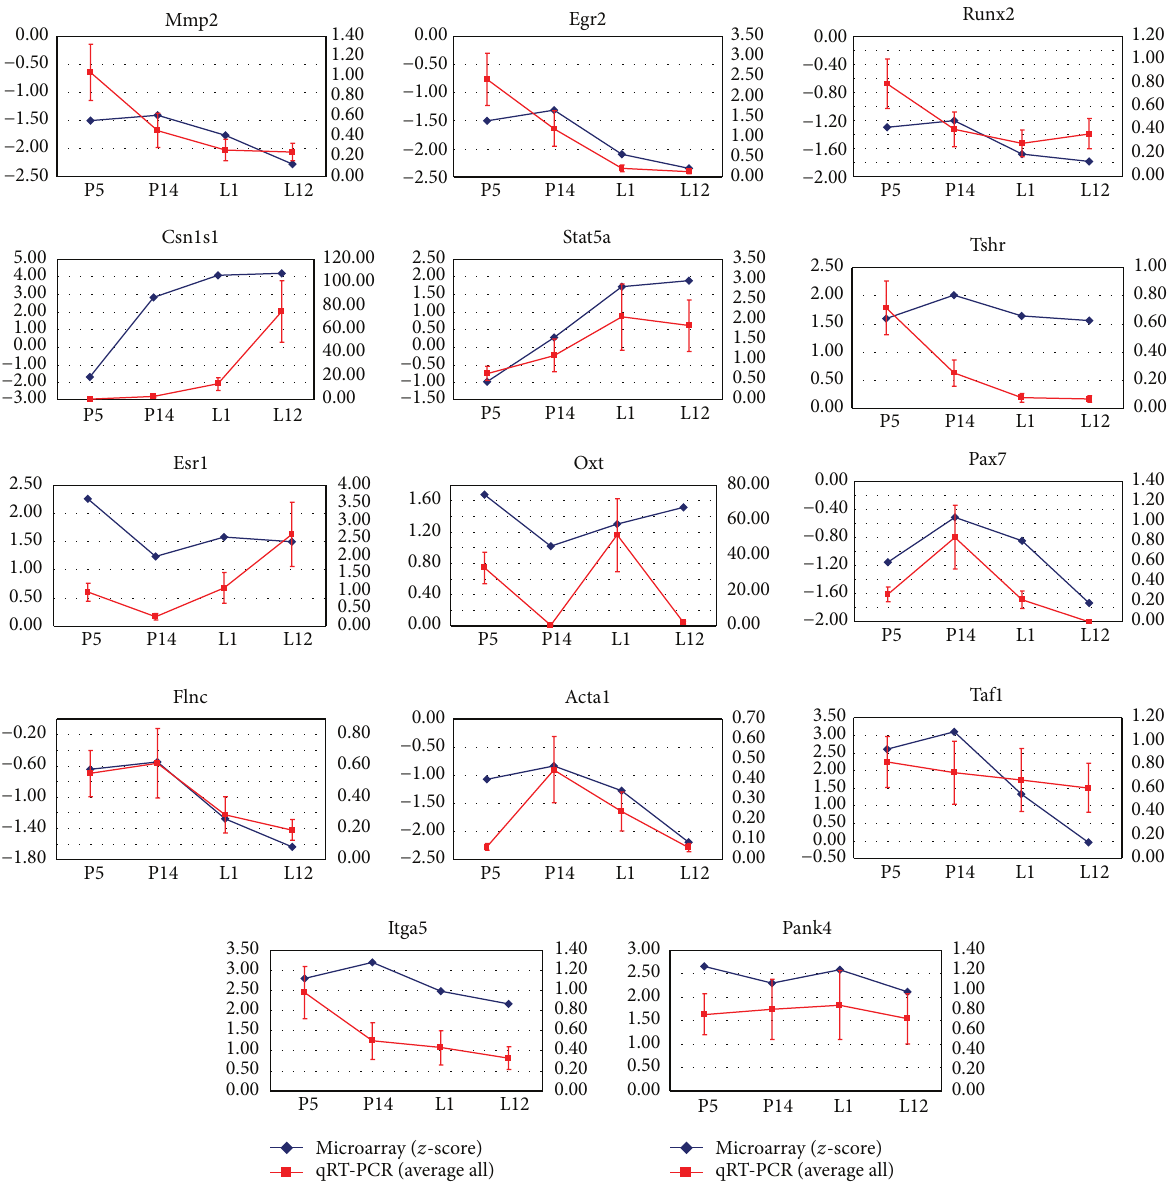
Figure 5: Validation of differentially expressed genes identified by microarray using qRT-PCR. Quantitative real-time-PCR was performed as in Experimental Procedures , and the calculated mean log ratio for each gene in their corresponding developmental stage was compared with the mean z -score from the microarray analysis during that same period. A positive value indicates a greater mRNA abundance in a developmental stage than in the control group, whereas a negative value indicates a lower mRNA abundance in a developmental stage than in the control group. Lines represent data obtained by qRT-PCR (red, right axis) and microarray analysis (blue, left axis), respectively, whereas the x -axis represents the physiological time point. The average fold change relative to time-matched virgin controls for three animals per group is shown. Genes are indicated by their official gene symbols. Data are presented as the mean of three independent experiments, each performed in triplicate. Error bars represent the SD for the average fold change. The correlation information in each analysis is indicated by Spearman rho value ( 𝑟 𝑠 ). All 18 pairs of genes had an absolute correlation value of 𝑟 𝑠 = 0.49 with a 𝑃 = 7.59𝐸 − 06 . ND: not